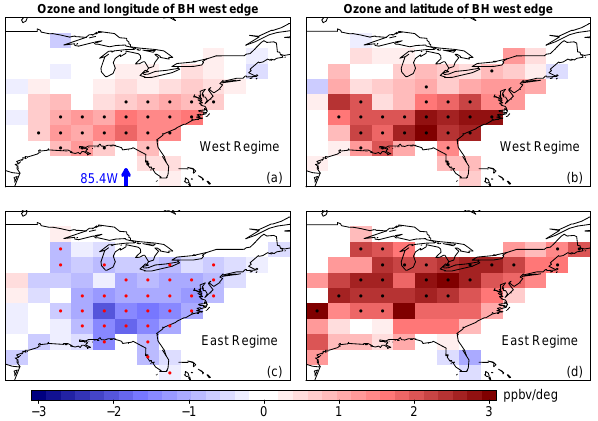
Figure 6. Relationship between the mean JJA MDA8 ozone in the eastern United States and the location of the Bermuda High west edge over the 1980–2012 time period. The plots show the slopes of anomalous ozone vs. longitude (BH-Lon) or latitude (BH-Lat) of the west edge, with the ozone anomalies calculated as the residuals of a 7-year moving average in the AQS data for each grid box. Pos- itive values indicate increasing ozone with westward or northward shifts of the longitude of the Bermuda High west edge. ( a and b ) show results for those summers when the west edge was located in the West Regime, with the 1560gpm isoline crossing the 850hPa wind ridge line west of 85.4 ◦ W. ( c and d ) show results for the East Regime, when the 1560gpm isoline crossed the 850hPa wind ridge line east of 85.4 ◦ W. The location of 85.4 ◦ W is denoted by the blue arrow in (a) . Red and black dots indicate those grid boxes where the slope is significant at the 0.10 level. For more details on the definition of the Bermuda High west edge for each regime, see text.